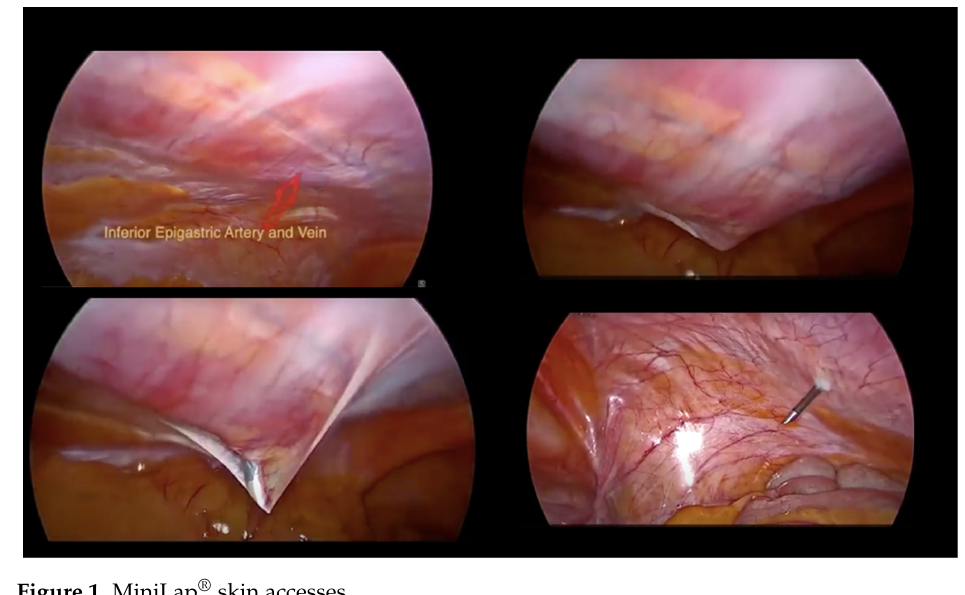
Figure 1. MiniLap ® skin accesses.